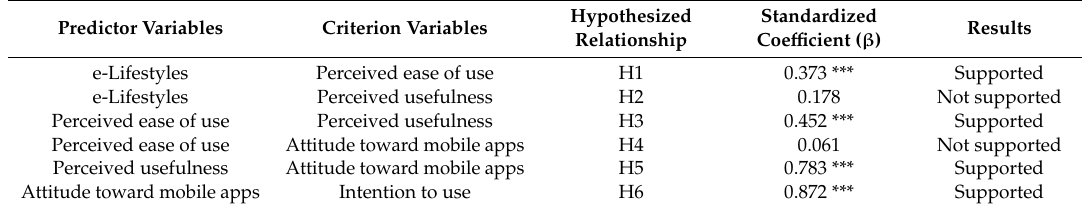
Table 3. Standardized regression weights for the causal paths.